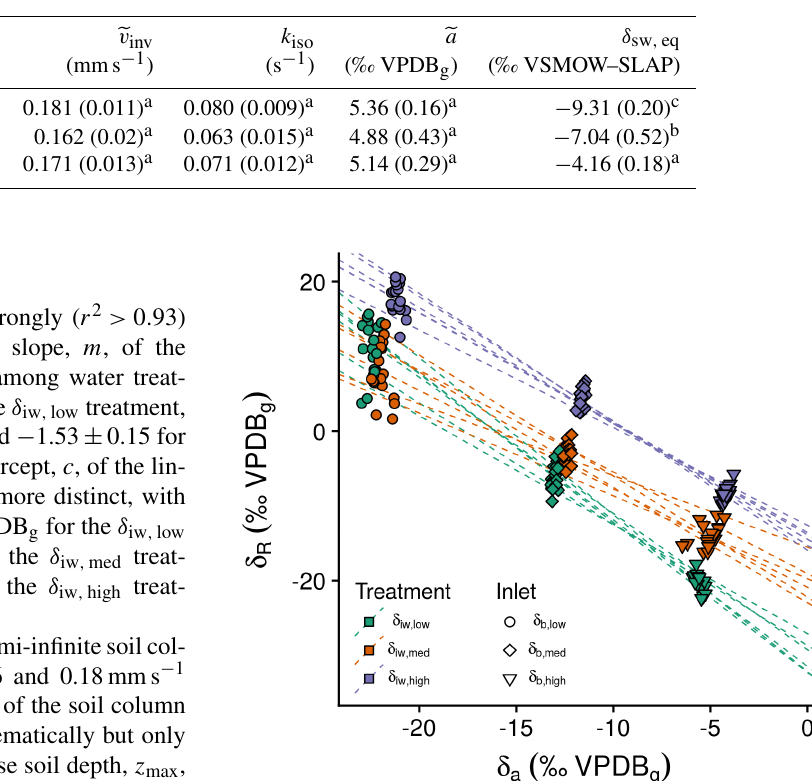
Table 3. Model solutions by irrigation water ( δ iw ) treatment. Means ( n = 6) and standard deviations (in parenthesis) for the piston velocity of CO 2 assuming a semi-infinite soil depth ( v inv ), the piston velocity of CO 2 assuming a finite soil depth ( e v inv ), the apparent rate of exchange between CO 2 and soil water ( k iso ), the effective diffusional fraction of CO 2 assuming a finite soil depth ( e a ), and the δ 18 O of soil water in equilibrium with CO 2 as determined from gas flux measurements ( δ sw , eq ). Superscript letters following each mean and deviation indicate significant differences (one-way analysis of variance and Tukey’s HSD, p < 0 . 01) among δ iw treatments.